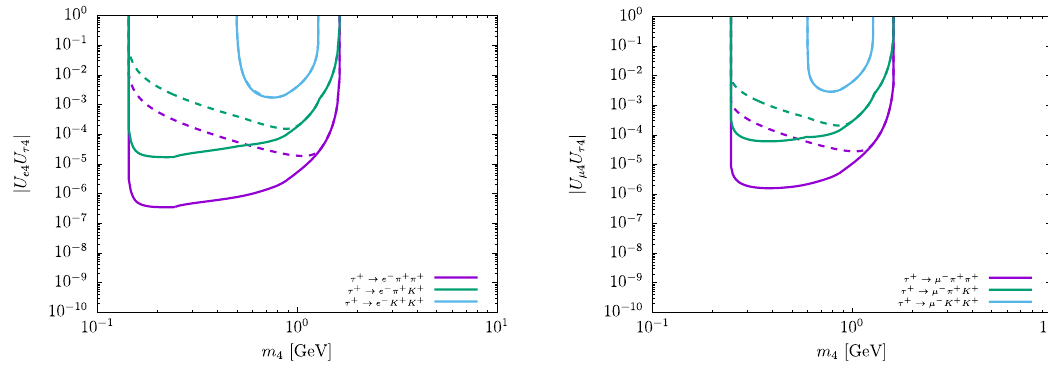
Figure 7 . Updated constraints on the relevant combination of leptonic mixing matrix elements ( j U ‘ U (cid:28) 4 j ) arising from LNV semileptonic tau decays, as a function of the heavy sterile neutrino (cid:11) 4 mass (GeV). Leading to the above plots, all active-sterile mixing angles were taken to be equal (i.e., j U e 4 j = j U (cid:22) 4 j = j U (cid:28) 4 j ). Line and colour code as in (cid:12)gure 5.